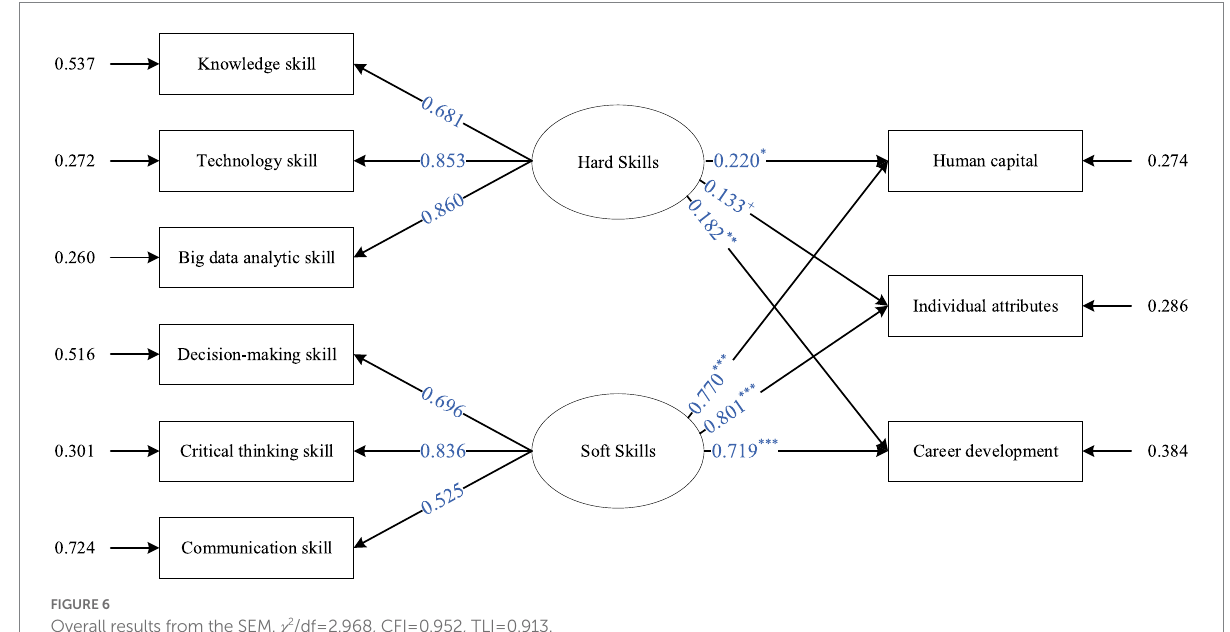
FIGURE 6 Overall results from the SEM. χ 2 /df = 2.968, CFI = 0.952, TLI =